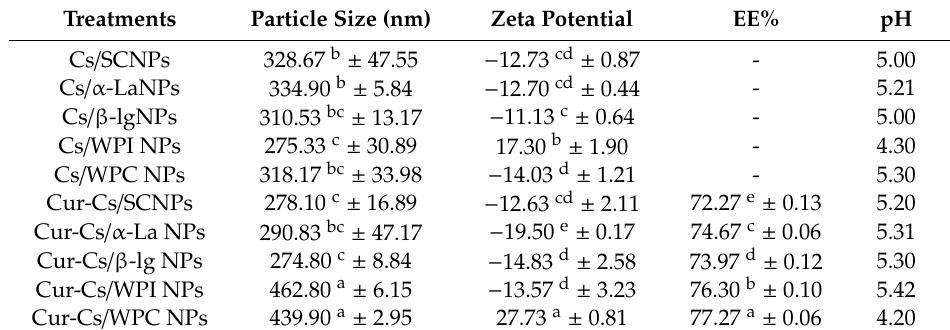
Table 1. Particle size, zeta potential and entrapment e ffi ciency (EE %) of curcumin-loaded milk protein